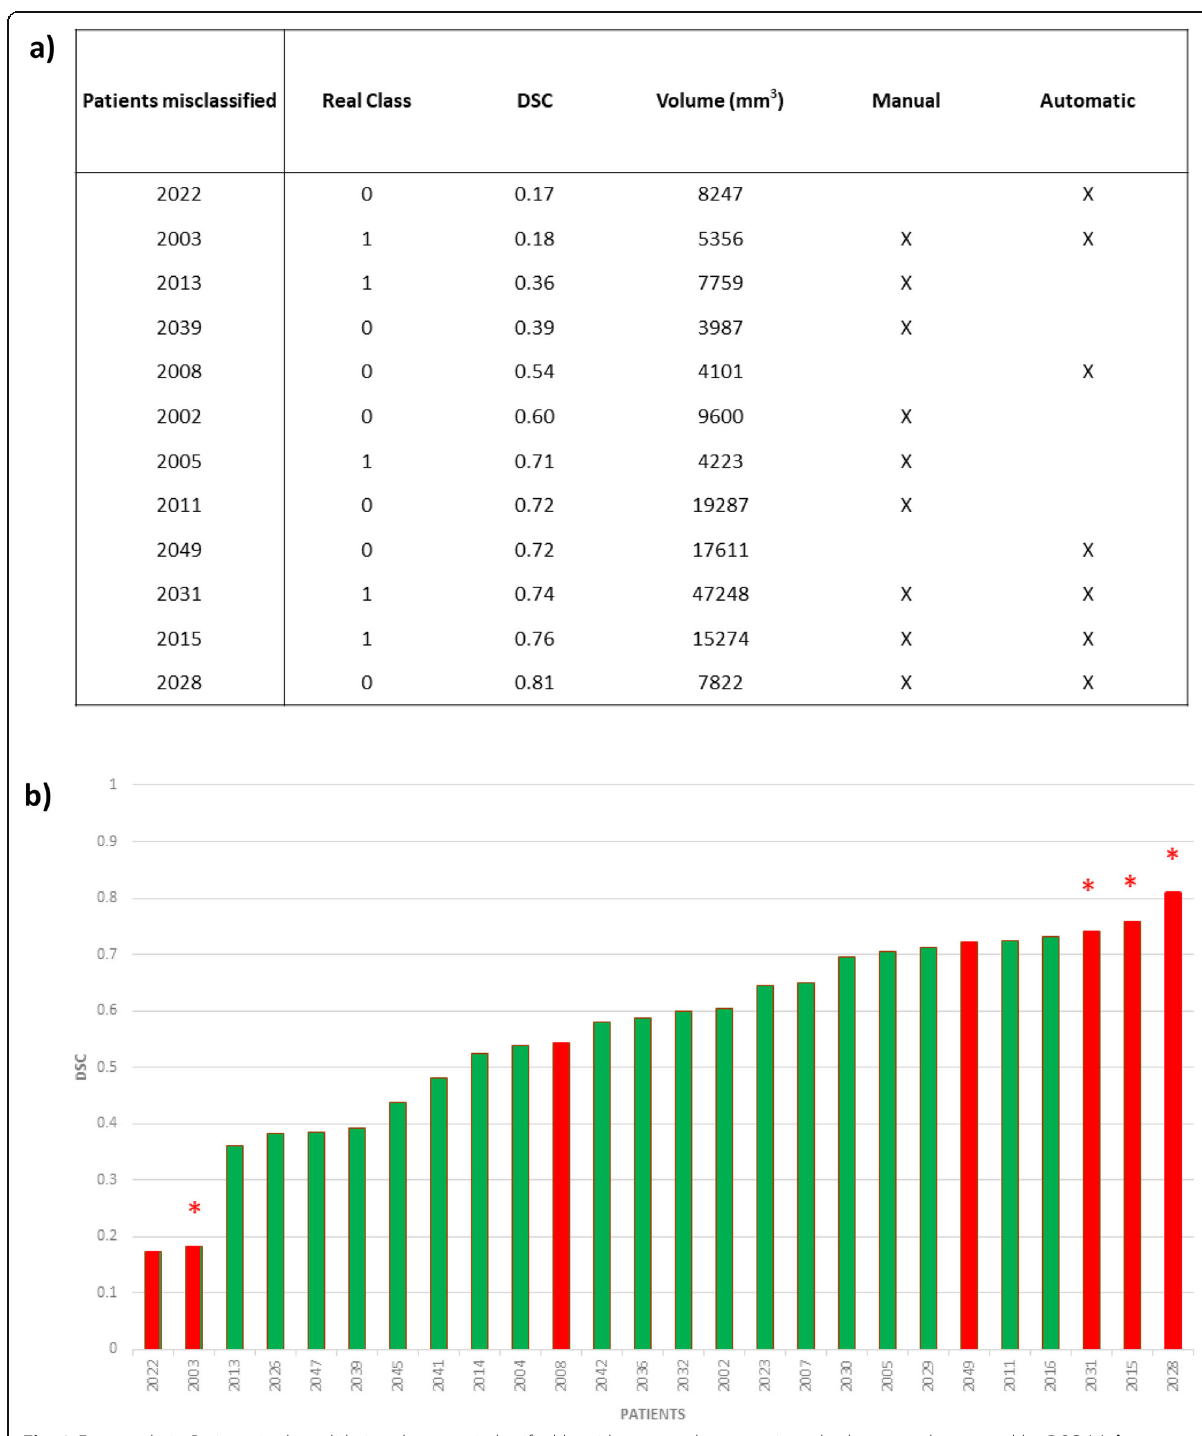
Fig. 3 Error analysis. Patients in the validation dataset misclassified by either manual, automatic, or both approaches, sorted by DSC ( a ). b Waterfall diagram showing DSC distribution across the validation set for the automatic approach ( b ). Red bars are the automatic model misclassified errors and green bars the correct ones. Red * highlights patients misclassified by both approaches. DSC Dice similarity